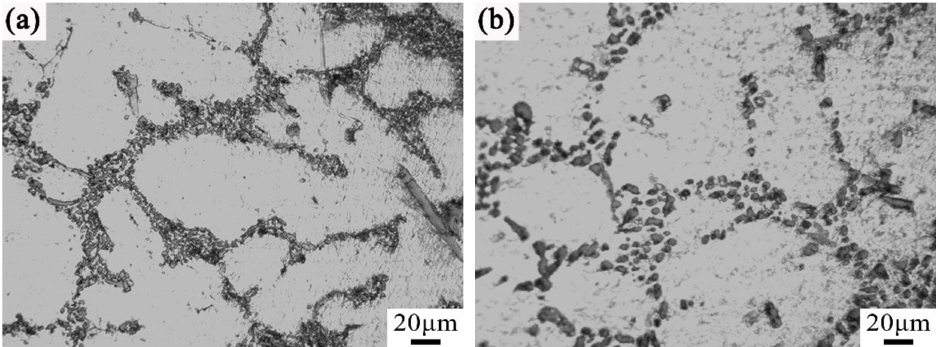
Figure 3. The microstructure of the Al-7Si-0.55Mg alloy: ( a ) As-cast and ( b ) with conventional heat treatment.